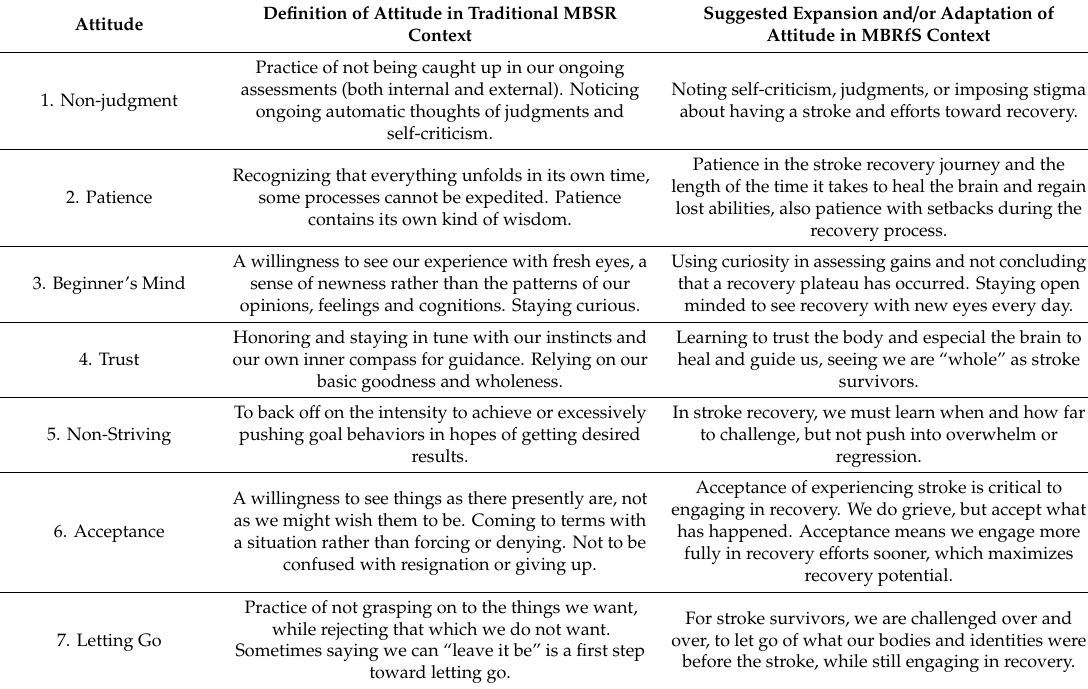
Table 2. Introduction and expansion with reframing the attitudes of mindfulness in the context of stroke